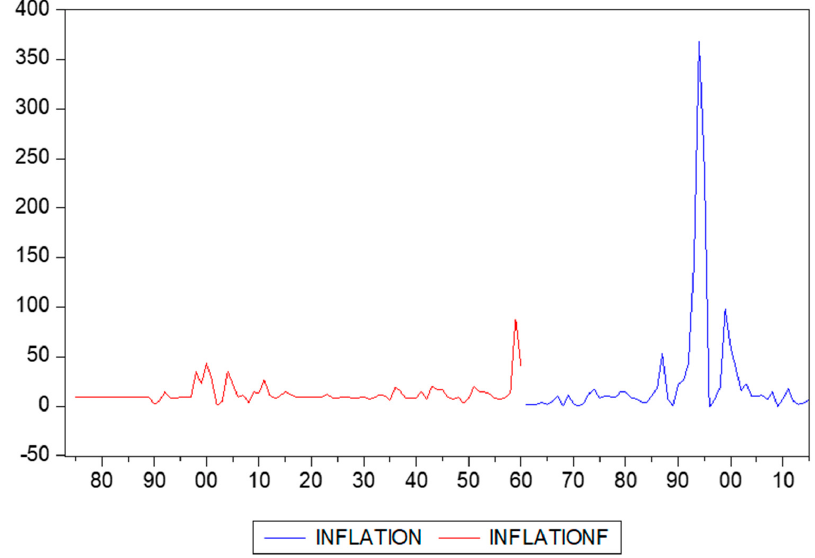
Figure 10. True and estimated inflation rates.